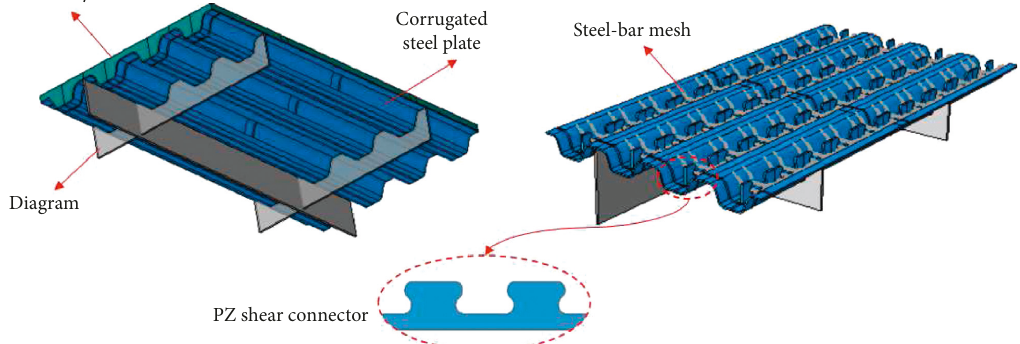
Figure 3: Corrugated steel plate-UHPC composite bridge deck with PZ shear connectors.